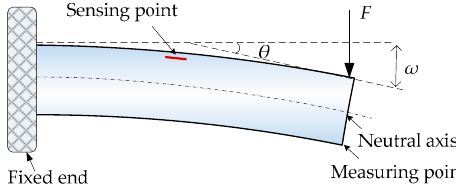
Figure 1. Measurement mechanism of each of the beam.